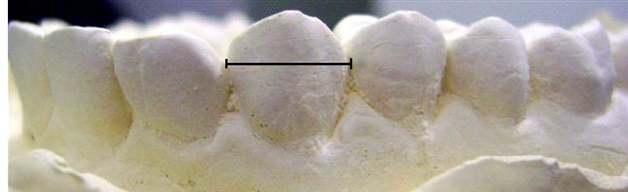
Fig. 1. Sense of mesiodistal measurement. Source: Direct research.